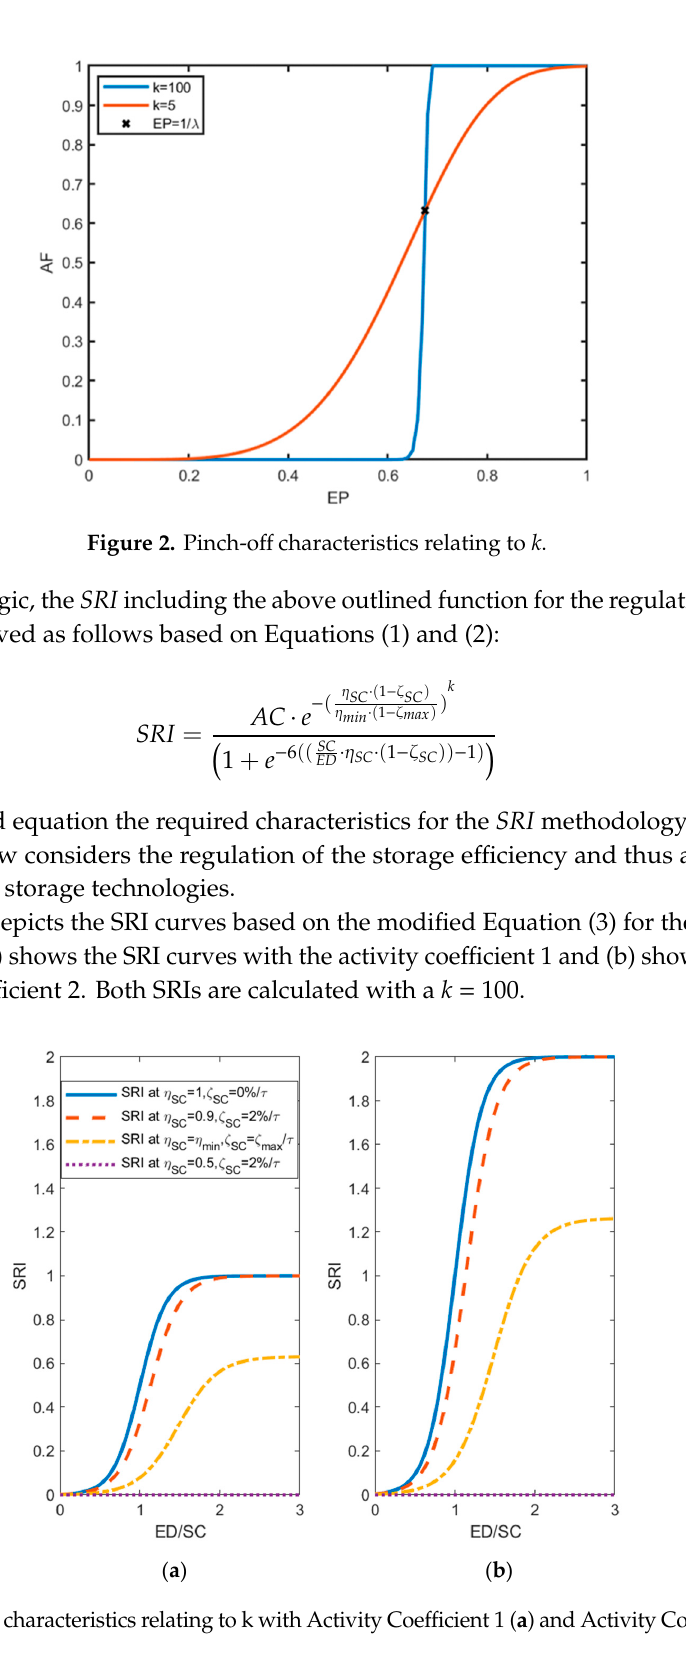
Figure 3. Pinch-off characteristics relating to k with Activity Coefficient 1 ( a ) and Activity Coefficient 2 ( b ).